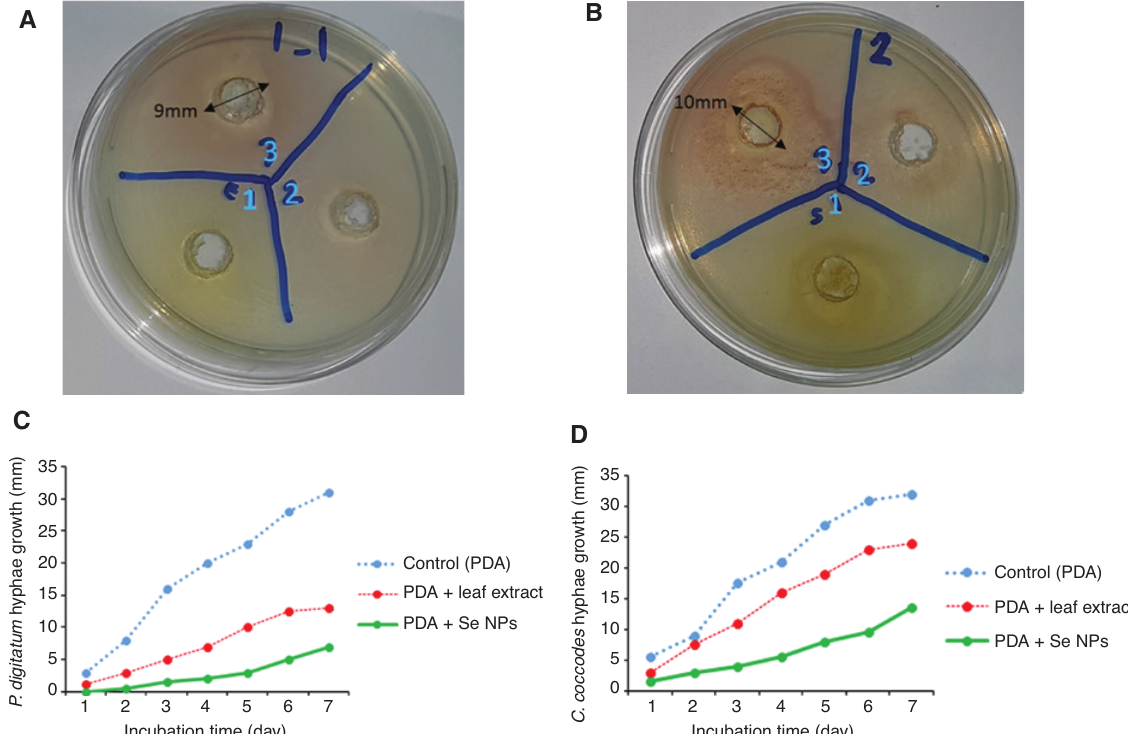
, absorbance with acceptable levels as a function of amount of Na Figure 3: Overlaid contour plot of λ max leaves extract (PLE) (ml) (A), UV-Vis spectra (B), particle size distribution (C) and transmission electron microscopy (TEM) image (D) of the synthesized selenium nanoparticles (Se NPs) at obtained optimum conditions.